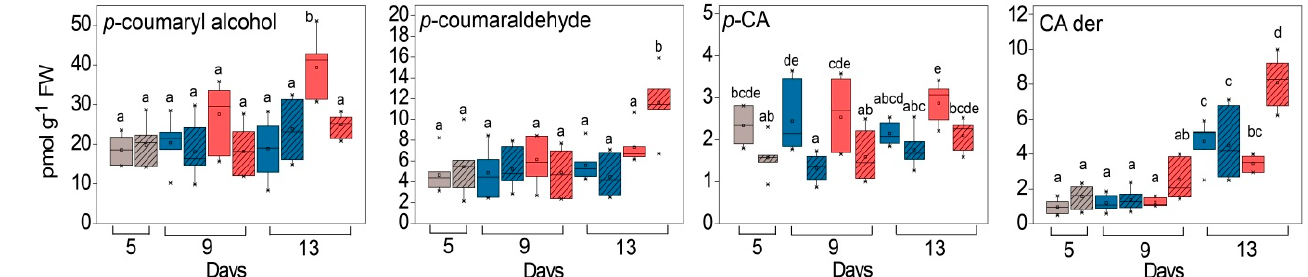
Figure 11. Content of cell-wall-bound hydroxycinnamates in GL (solid boxes) and WL (striped boxes) of P. zonale plants prior to (5 d, grey) and after four (9 d) and eight days (13 d) of exposure to high light (HL, 800 µmol m –2 s –1 , red) compared to those exposed to low light (LL, 180 µmol m –2 s –1 , blue) at lower temperature, 18 °C ( Cold + HL ). Values are shown in pmol g –1 FW ± SE, n = 7–9. Different letters denote statistically significant differences between different PAR intensities, time points, and leaf tissues ( p < 0.05) according to Tukey’s post hoc test. p -CA der 2, p -CA derivative with Rt = 18.57 min; CA der, caffeic acid derivative with Rt = 22.5 min (Supplementary Figure S2).